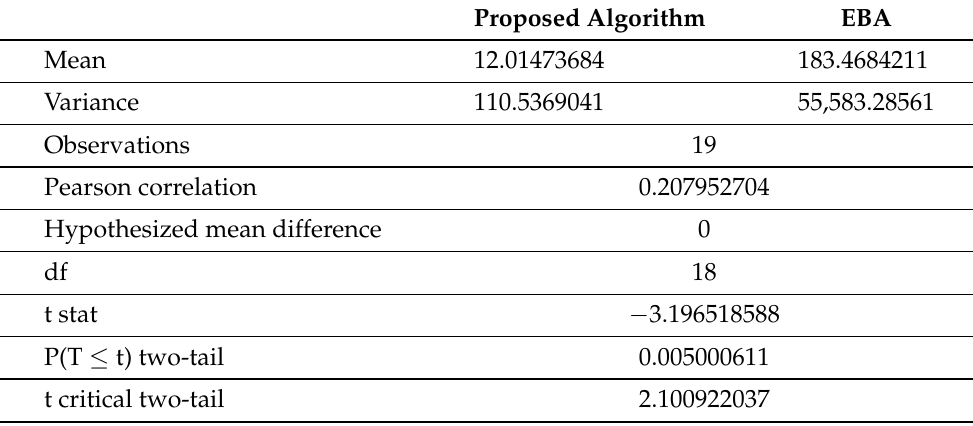
Table 3. Statistical significance of proposed algorithm and EBA